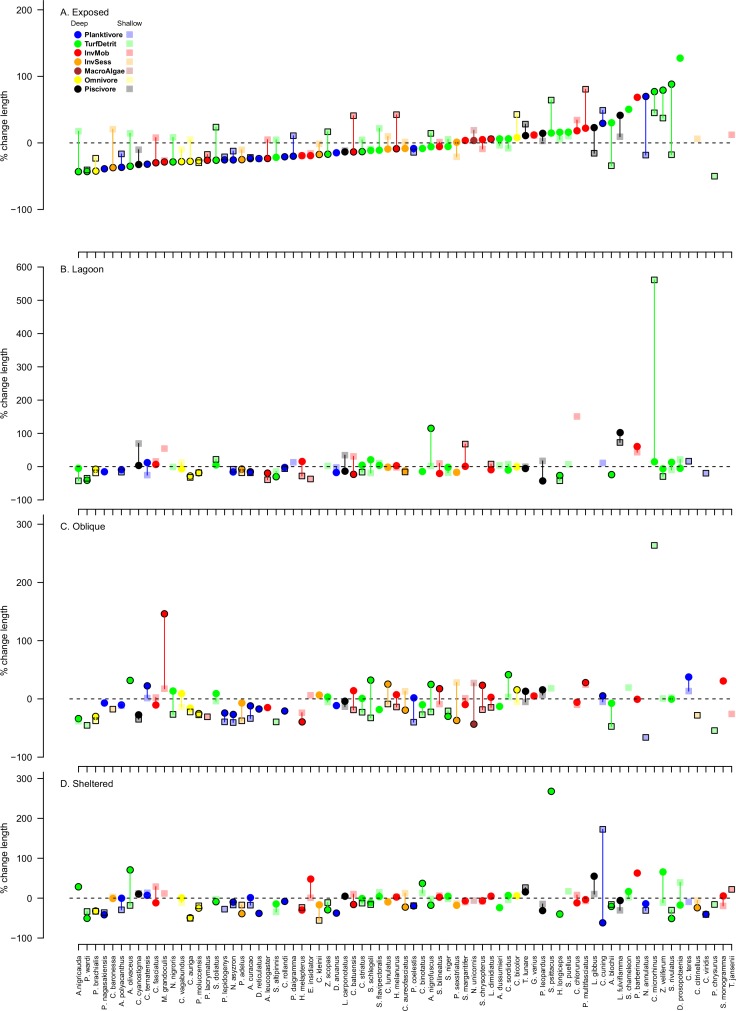
Average percentage change in the total length (cm) of individual fish species between 2011 and 2015 for A. exposed, B. lagoon, C. oblique and D. sheltered sites of Lizard Island. Fish species were only included in analyses if there were at least 10 individuals in both years. The y axis is the percent change in fish total length. Colours represent trophic affiliations: blue = planktivores, orange = sessile invertebrate feeders, white = omnivores (feeding on both plant and animal matter), green = turf and detritus feeders, red = mobile invertebrate feeders, black = piscivores and dark red = macroalgal feeders. Symbols with black outlined represent species for which total length changed significantly at that depth-exposure combination. Vertical lines link deep and shallow symbols for each species are for ease of observation.